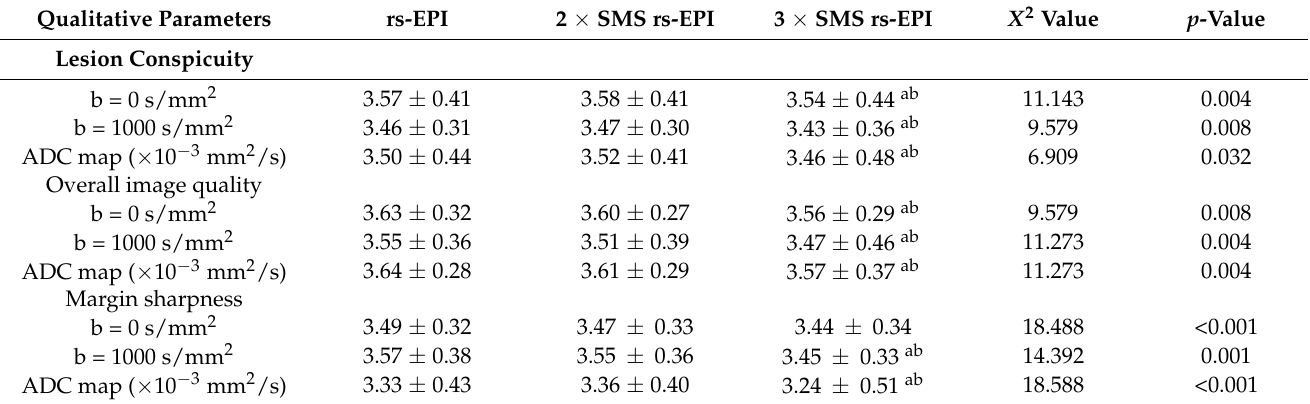
Table 3. Comparison of three rs-EPI sequences showing subjective scores of rectal image quality.